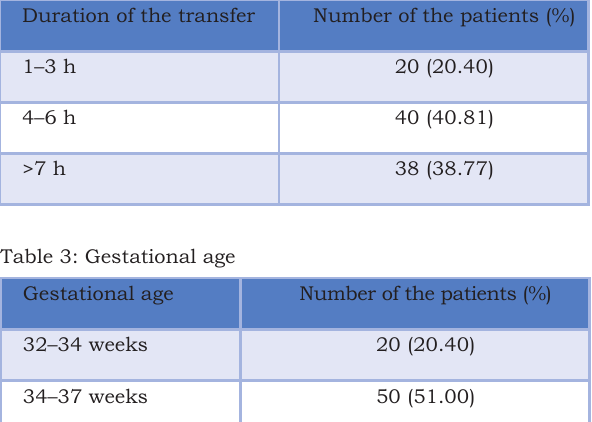
Table 2: Time elapsed before transfer Duration of the transfer Number of the patients (%)